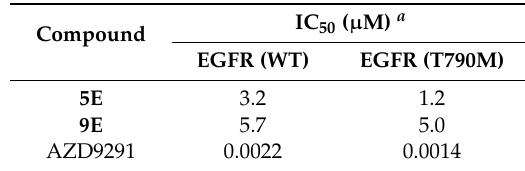
Table 2. The inhibitory activity of compounds 5E and 9E against wild type EGFR and EGFR with T790M mutation.